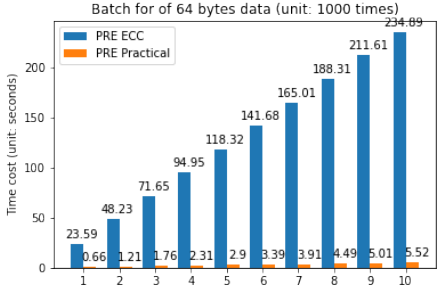
Figure 4. Time cost for PRE ECC and practical encryption for every 1000 times of encryption of 64 bytes data on MacBook 1.3 GHz Intel Core